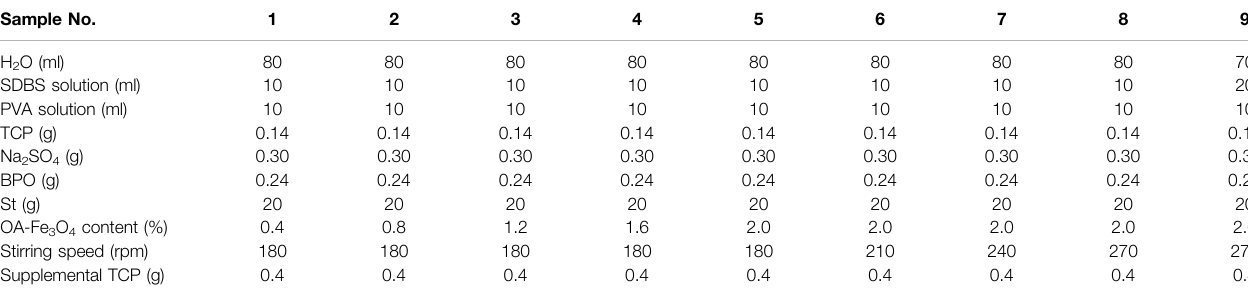
TABLE 1 | Recipes of the synthesis of PS/Fe 3 O 4 composite beads. Sample